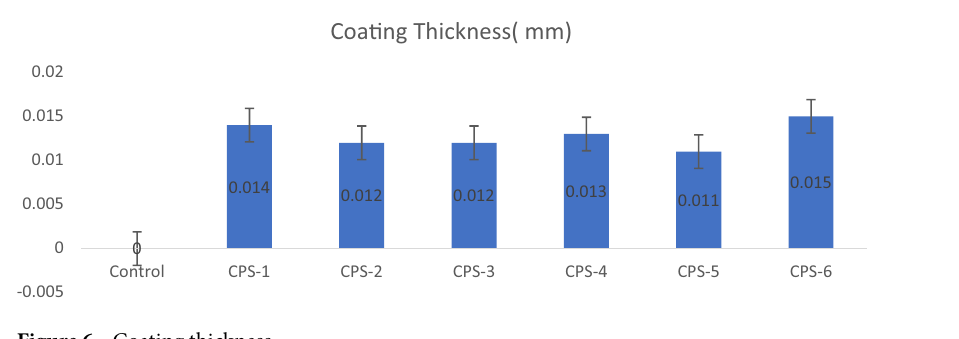
Figure 6. Coating